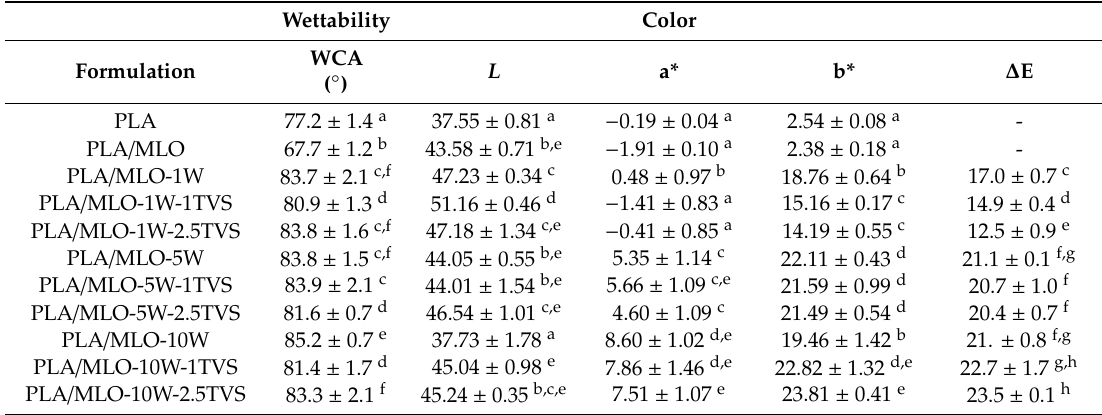
Table 3. Wettability and CIELab color